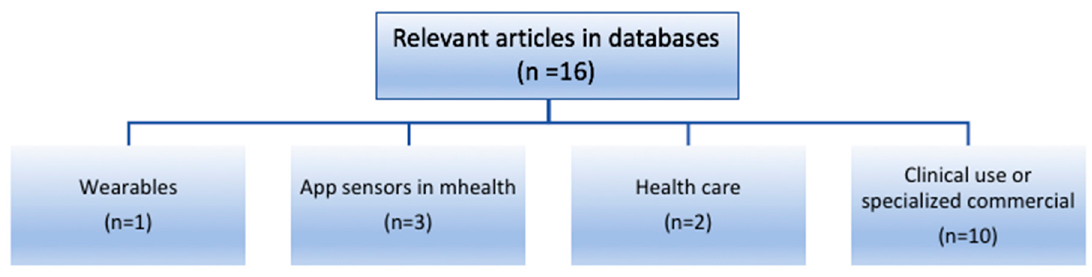
Figure 1. Methodology in the